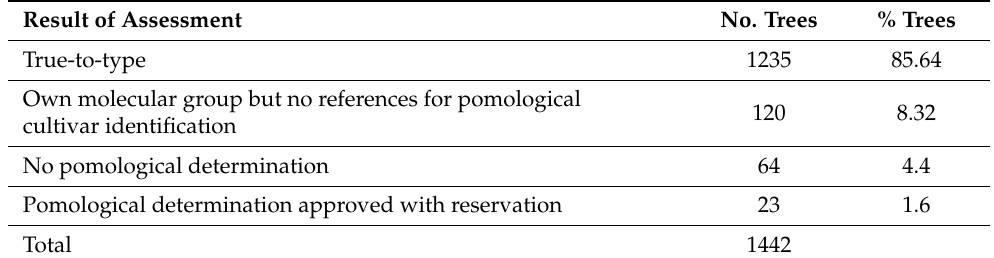
Table 1. Determination of true-to-type cultivars based on pomological and molecular analyses of sweet cherry trees from the German Fruit Genebank (six partners